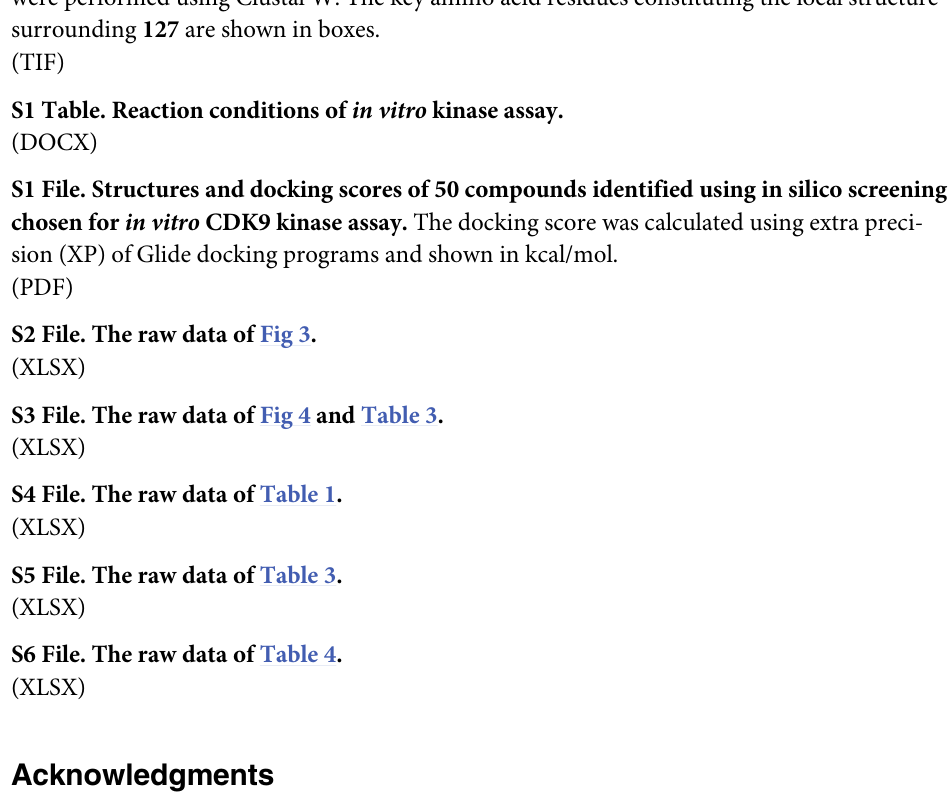
S1 Fig. Sequence comparison of CDK9 and other CDKs. Amino acid alignments of CDKs were performed using Clustal W. The key amino acid residues constituting the local structure surrounding 127 are shown in boxes. S1 Table. Reaction conditions of in vitro kinase assay. S1 File. Structures and docking scores of 50 compounds identified using in silico screening chosen for in vitro CDK9 kinase assay. The docking score was calculated using extra preci- sion (XP) of Glide docking programs and shown in